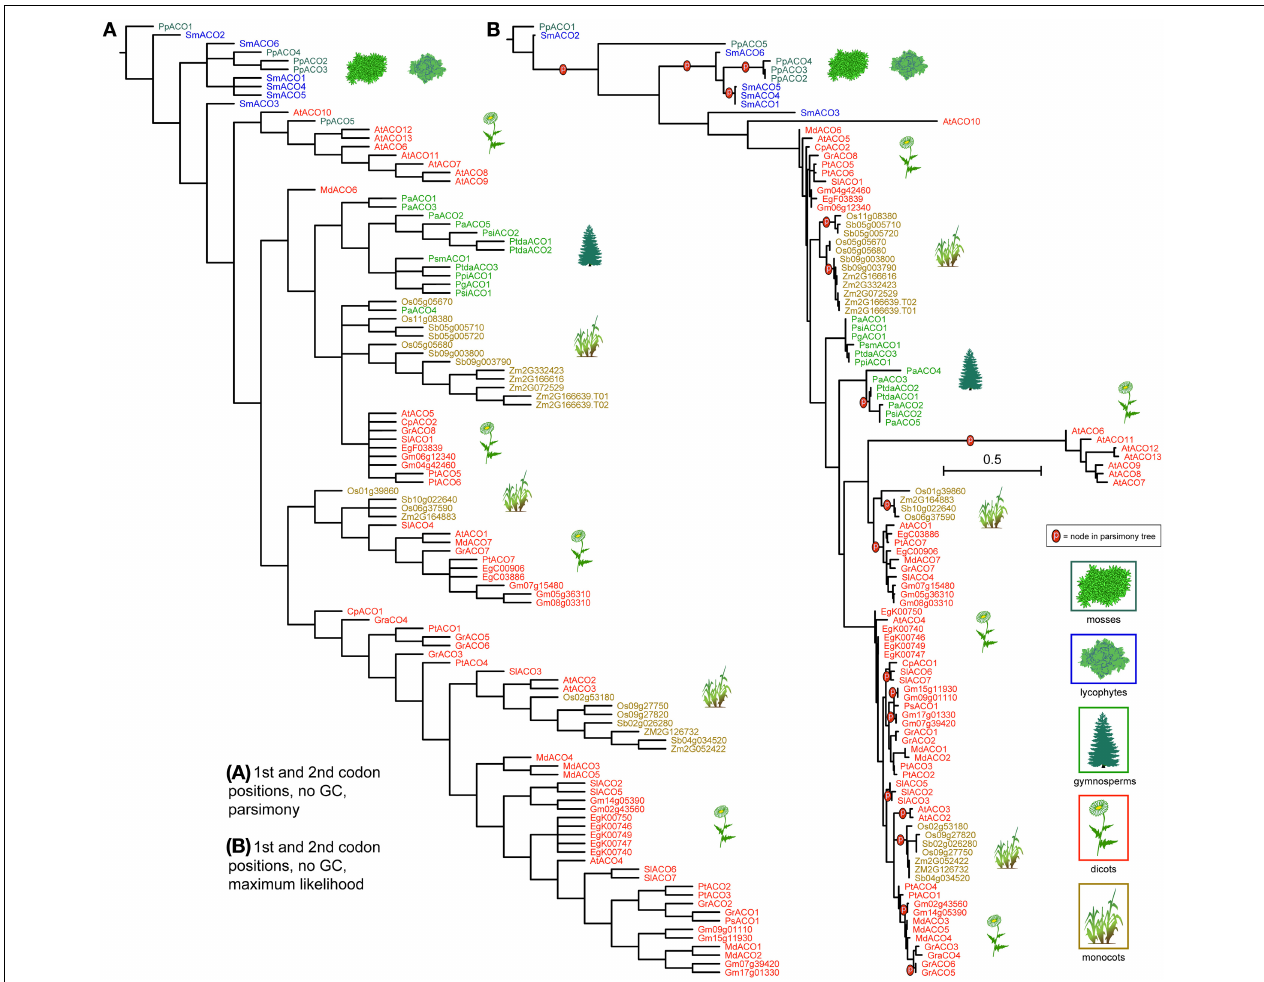
FIGURE 6 | Phylogeny of the ACO genes, using only the 1st and 2nd codon positions and with al Gs and Cs converted to “N.” The strict consensus of 42 equally parsimonious trees is shown in (A) , and the most likely tree under the GTR model is shown in (B) . Terminals are